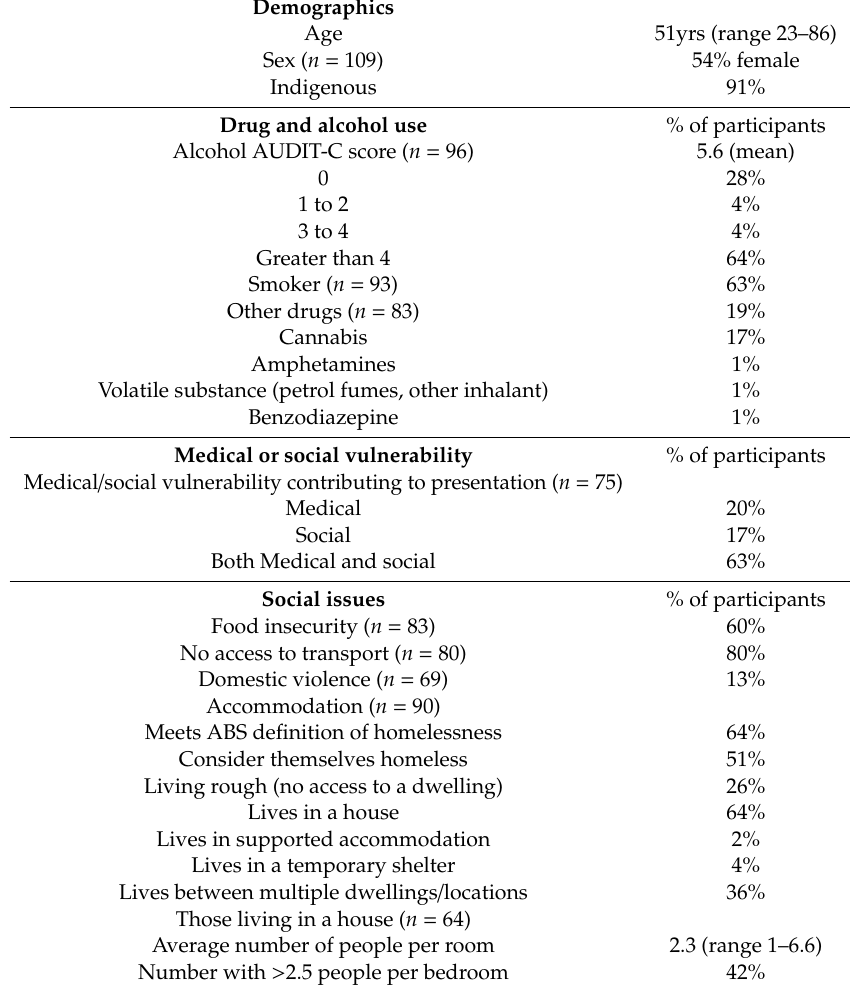
Table 2. Demographics and social indicators at